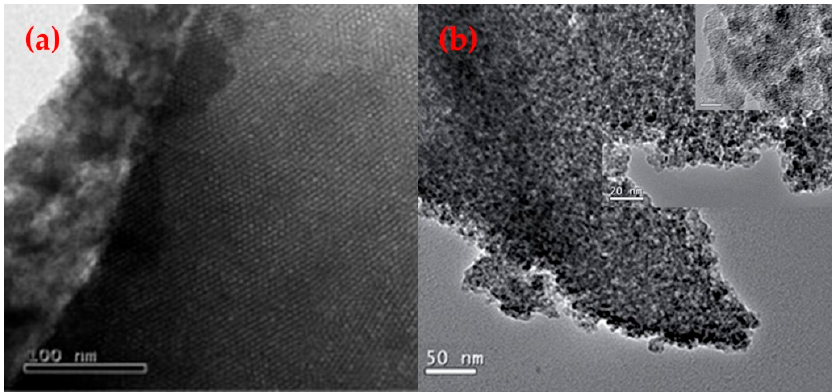
Figure 5. TEM images contrasting the mesoporous framework-substituted Al-MCM-41 species ( a ) with the extra-framework Nb sites in Nb/HMS-X (Si/Nb = 2) ( b ) (adapted from references [51,55]).